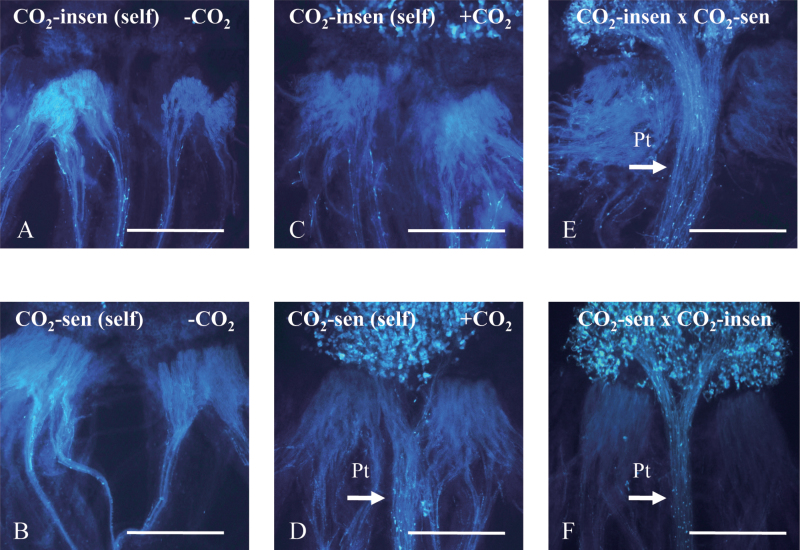
Phenotype of inbred Brassica rapa lines used in this study. (A, B) Pollen tube behaviour after self-pollination of CO2-sensitive (HA-11621) and CO2-insensitive (HA-11623) lines under normal conditions (without CO2 treatment). No penetrated or elongated pollen tubes are observed in either line. (C, D) Pollen tube behaviour after self-pollination of CO2-sensitive and CO2-insensitive lines under 4.5% CO2 gas treatment. Pollen tubes could penetrate into the stigma and elongate through the style only in the CO2-sensitive line. (E, F) Cross-pollination as a positive control; the arrow shows pollen tubes which have penetrated. Pt, pollen tubes. Bar=1000 μm.